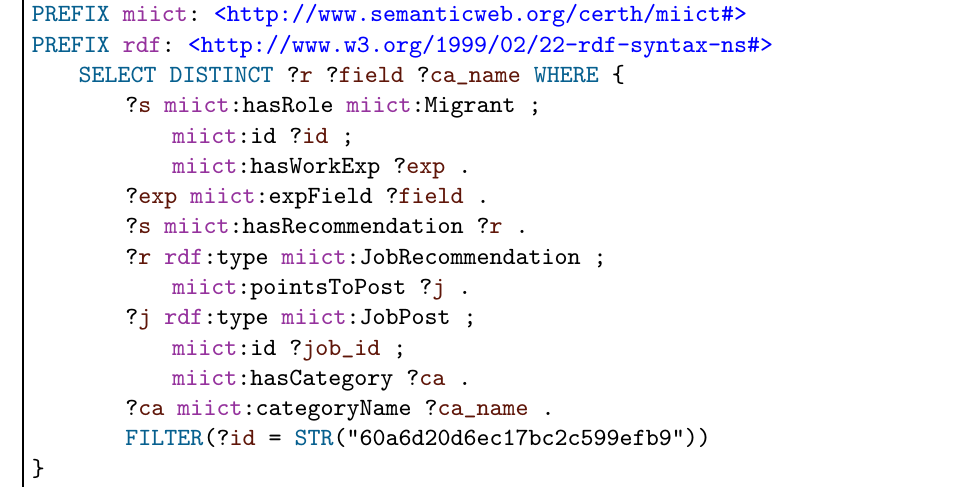
Figure 11. CQ_04: Which job posts match the migrant’s work experience?